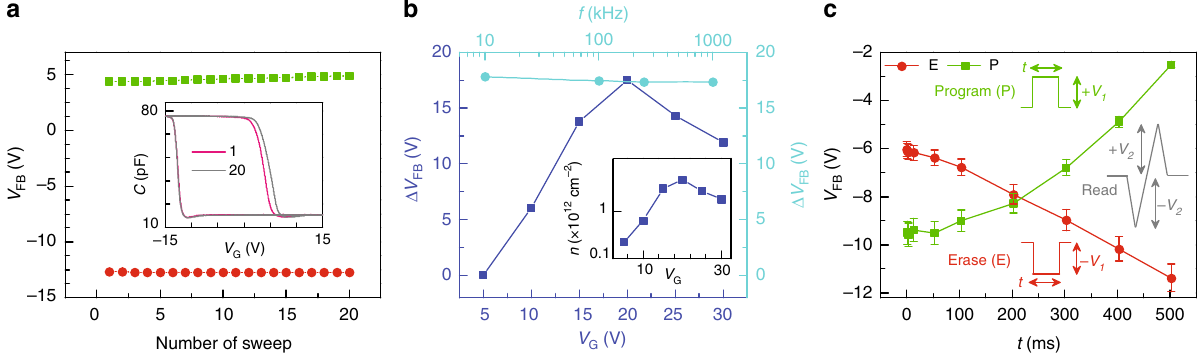
Fig. 2 Program-disturb (PD) measurement. a PD measurement with 20 times C – V sweep on same device. Inset: C – V curve of fi rst and 20th measurement, where V FB , C FB , and V G are indicating fl atband voltage, fl atband capacitance and Gate voltage respectively. b Flatband voltage shift ( Δ V FB ) as a function of gate sweep voltage and frequency of sweep voltage. (Inset) Charge density variation as a function of gate voltage ( V G ). c Programming (P) and erasing (E) operations of the fl ash memory device as a function of time period ( t ) of the input pulse. The error bar represents 5% uncertainty in the measured values. Insets indicate shape of the pulses used for program (P), erase (E), and read